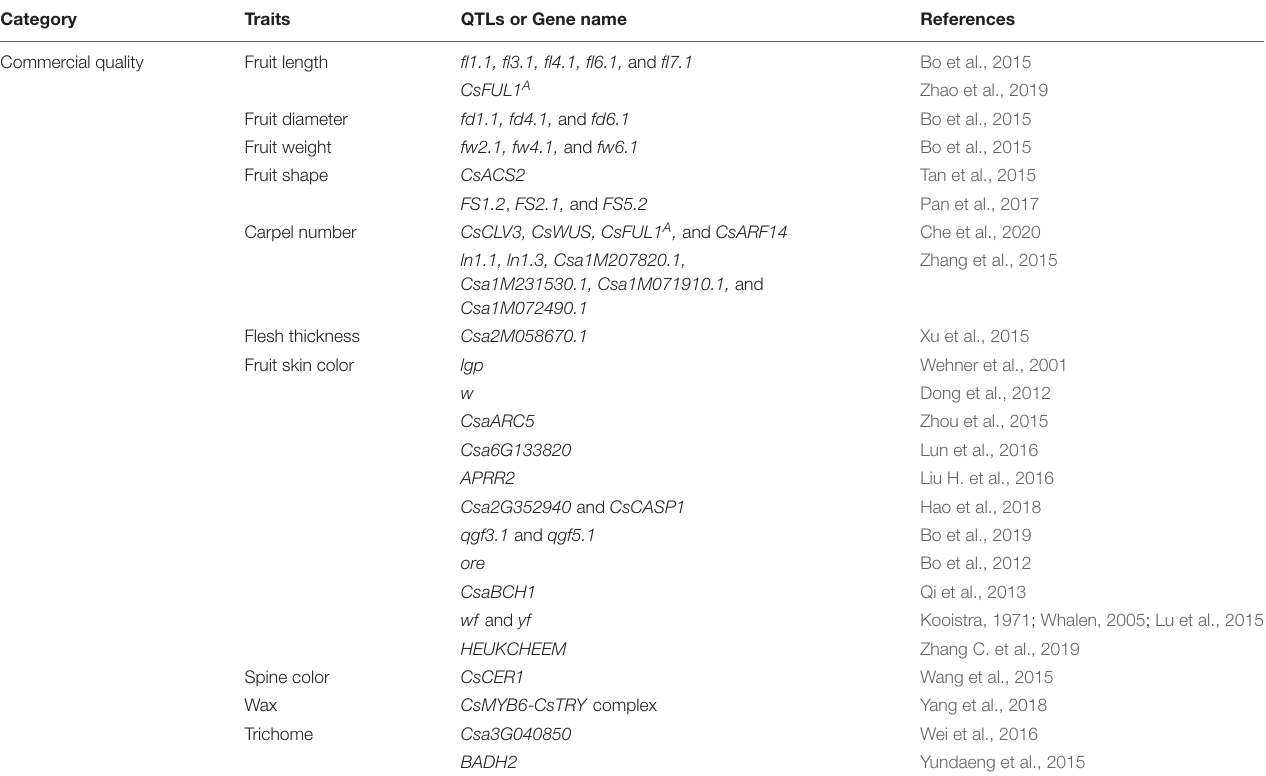
TABLE 1 | Genes related to the commercial quality of cucumber